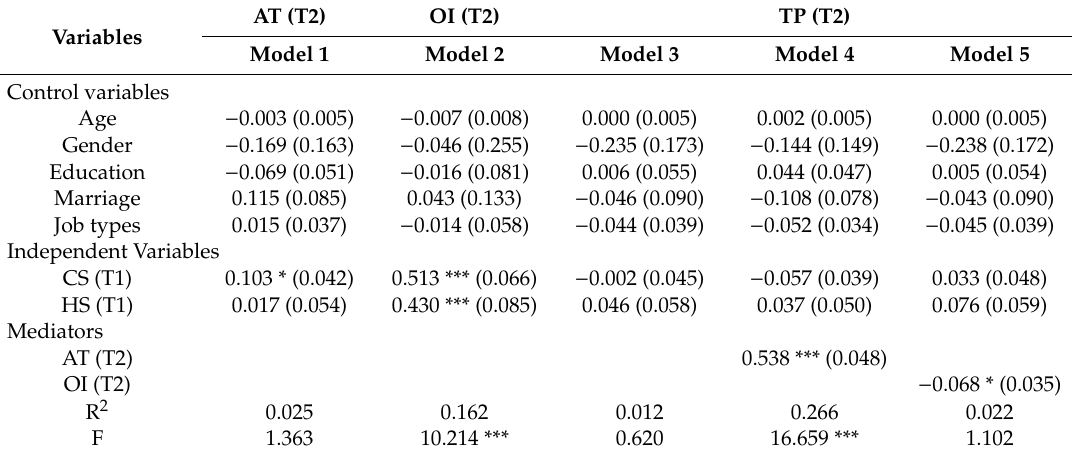
Table 3. Results of the regression